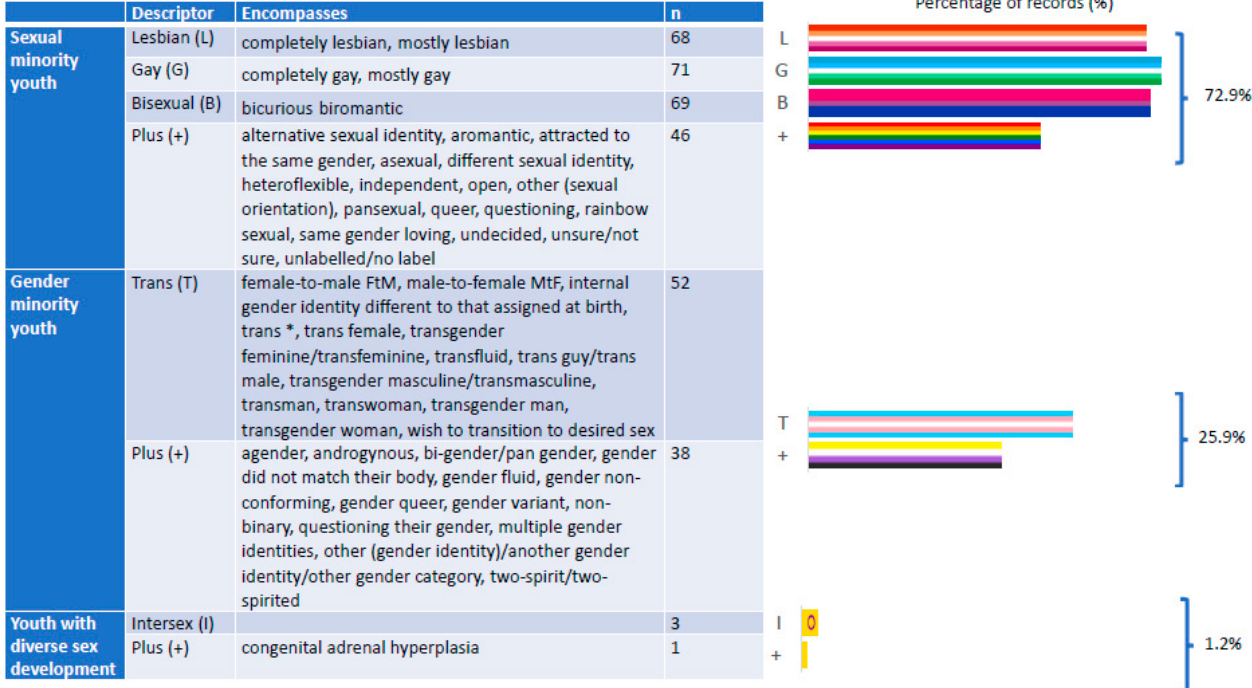
Figure 4. Self-descriptors and proportion of records focused on sexual minority youth, gender minority youth and those with diverse sex development.